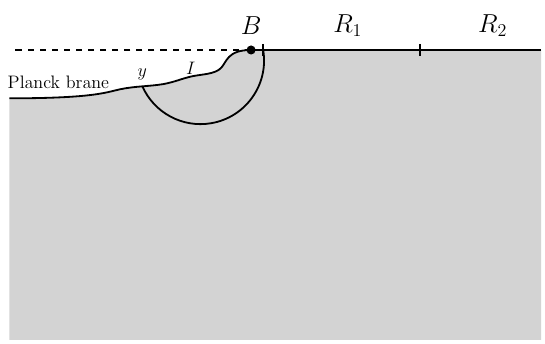
Figure 42 . A system with holographic